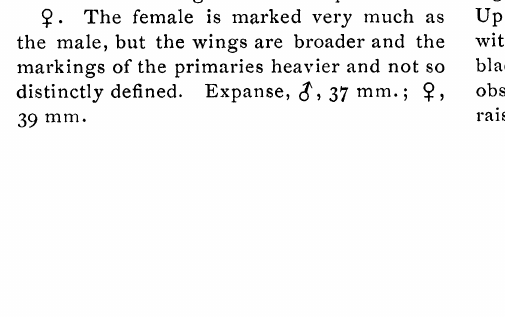
. An. Palpi tennae dark brown; fl’ont, collar, and upper on the tinder side pale brown; front dark side of thorax olive-green; legs and pectus brown antennae testaeeous collar, tegulae, brown; lower side of abdomen whitish. and tipper side of thorax dark grass-green; Upper side: Primaries olive-green with a pale upper side of abdomen dark brown; end of whitish median fascia, beyond which are the abdomen tipped with dark green hairs; lower side of abdomen pale fulvous; legs three dark olive bands running parallel to it, and below the apex a similarly curved olive concolorous. Upper side: Primaries uni- formly dark grass-green with a multitude of line running outwardly and succeeded by a series of marginal olive dots. The basal area minute and vaguely defined spots and lines is dark olive with a large patch of blackish of slightly paler color, defined, especially on the margin, by very narrow lines of raised raised scales on the inner margin near the base. The fringes are dark brown. The see. brownish scales. The secondaries are uni- formly purplish-brown except on the costa ondaries are uniformly fuscous, the fringes paler. Under side: Both wings are pale and near the outer angle, where they are . fuliginous with the costae and outer margins tinged with pale green and marked by incom- narrovly pale gray. Expanse, 4 mm. plete bars of darker brown. Under side: The wings are purplish-brown, paler toward the base. Expanse, 36mm. Allied 139. S. biNoides, sp. nov. o to S. bitia, Stoil, but not so large, paler in color, and diff’erently marked. Antennae testaceous fi’ont whitish collar, tegulae, species, but the legs are heavily clothed with and upper side of thorax pale green; tapper side of abdomen pale brown; pectus dark brown; lower side of thorax and abdomen whitish; legs tinged with brownish. Upper side: Primaries pea-green with a profusion brown, defined outwardly and inwardly by of darker green and brown transverse lines dark green. On the cell and near the base and spots. The most conspicuous markings are a series of small brown spots running along the costa, a transverse limbal series of are bright yellow from the base to near the sagittate brown spots, of which the spot outer margins, which together with the costa upon the second and third median nervule are heavily bordered with dark brown. The is the most conspicuous. There is a sub- fringes are pale whitish. Under side: The marginal series of curved brown lines at the extremities of the interspaces. The secon- daries are rosy-brown, except on the costal margin near the outer angle, where they are tinged with greenish and marked by . three or four incomplete transverse bars of dark brown. Under side: The wings are uniformly pale purplish-brown, the secon- legs margined outwardly by dark olive. daries somewhat lighter than the primaries. The female is marked very much as , with the fringes regularly checked with the male, but the wings are broader and the blackish. At the end of the cell, there is an markings of the primaries heavier and not so distinctly defined. Expanse, ’, 37 mm. raised scales surrounding a paler space. 39 ram.